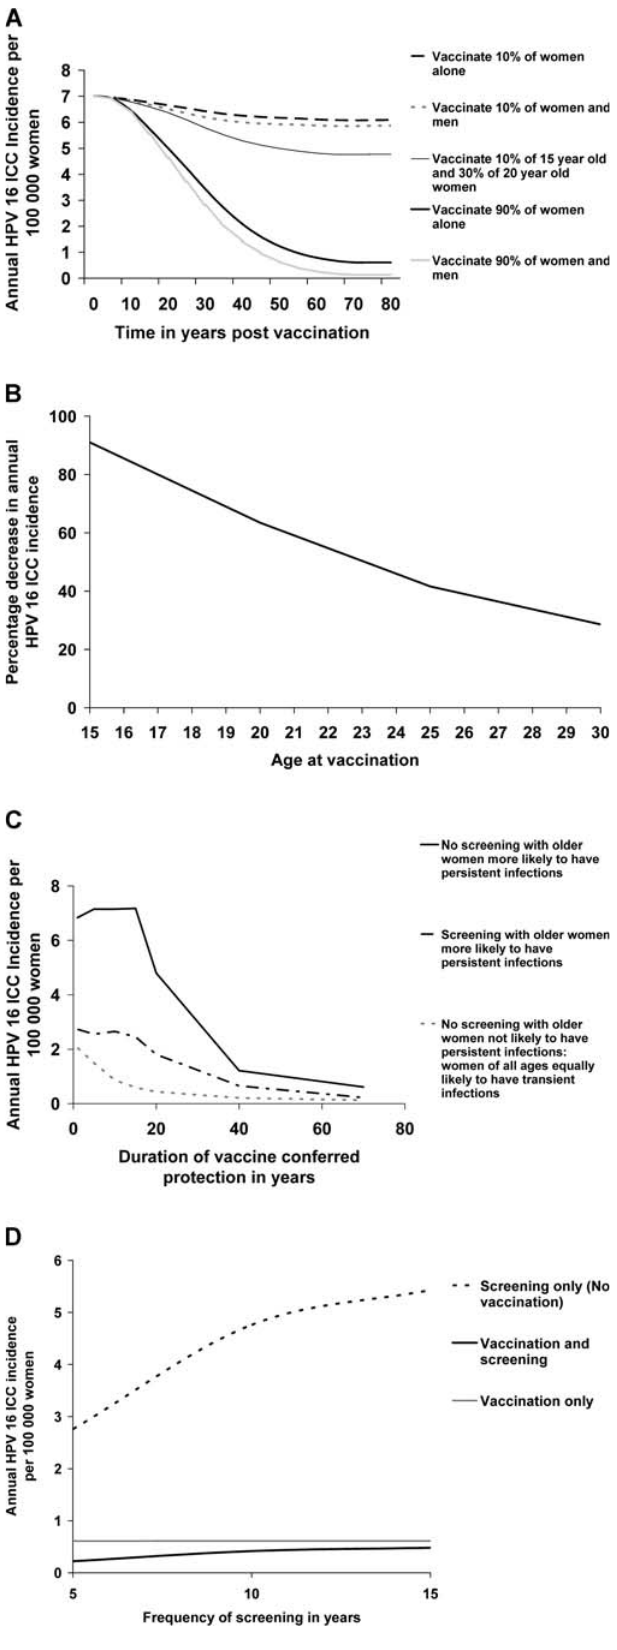
Figure 3. The Impact of Varying the Target Population for HPV 16